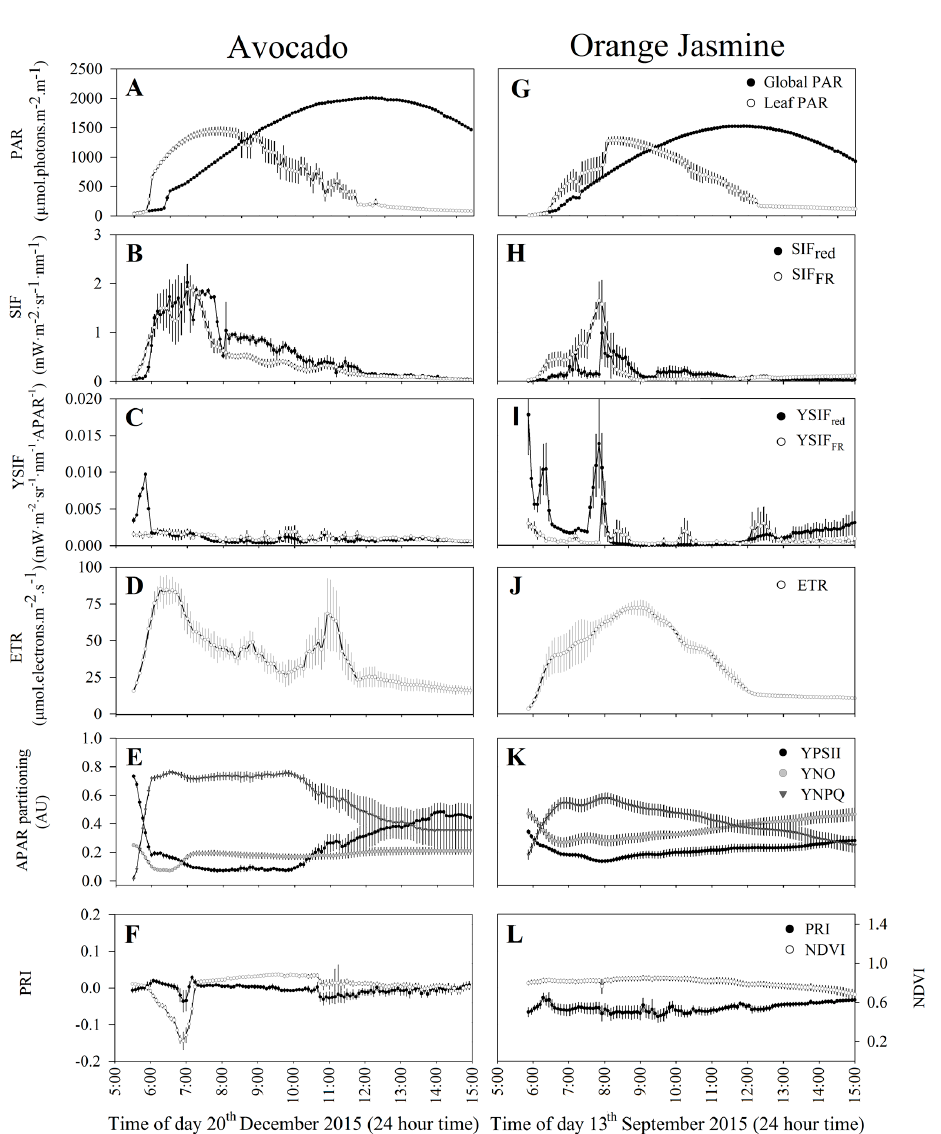
Figure 4. Diurnal changes in PAR, SIF, SIF yields, photosynthetic parameters and spectral indices measured using a LIFT instrument and QE Pro. The Y axis of each panel shows measured parameters as they change over a diurnal cycle. Each data point represents the mean ± SE (vertical bars) of six fully expanded avocado leaves from SHF ( A – F ) and orange jasmine leaves from UOW ( G – L ). All measurements were collected with a mean resolution of ~3 min ± 3 min per sample and have been smoothed using a centred moving average of the two following and previous measurements.